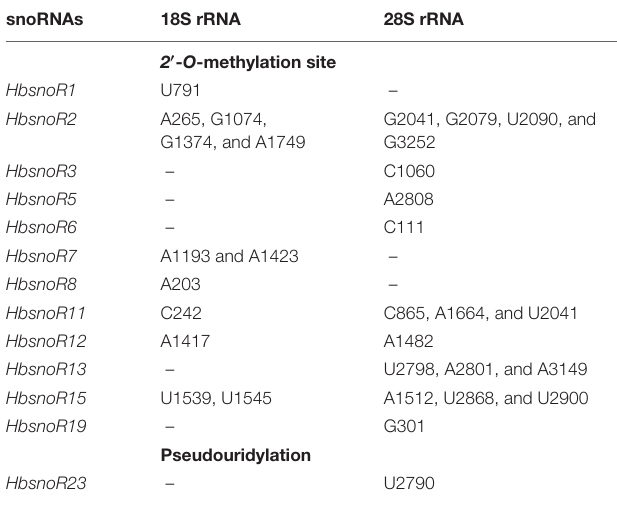
TABLE 4 | Targeted modification sites of 13 latex-abundant guide snoRNA on 18S and 28S